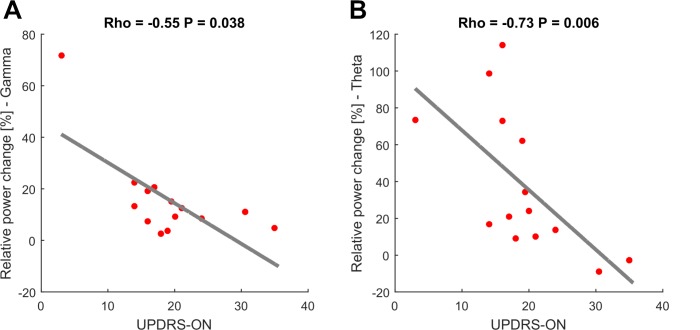
Movement-related theta and gamma oscillations are correlated with parkinsonian symptom severity in the dopaminergic ON state.To investigate a potential association of movement-related activity, Spearman’s correlations were conducted between averaged theta (2–8 Hz), beta (13–30 Hz) and gamma (40–90 Hz) amplitudes with concurrent motor impairment as assessed by UPDRS-III (available in 14/16 patients). Significant negative correlations were found for the theta (A; Spearman’s ρ = −0.073, p<0.01) and gamma (C; Spearman’s ρ = −0.55, p=0.038) amplitudes.